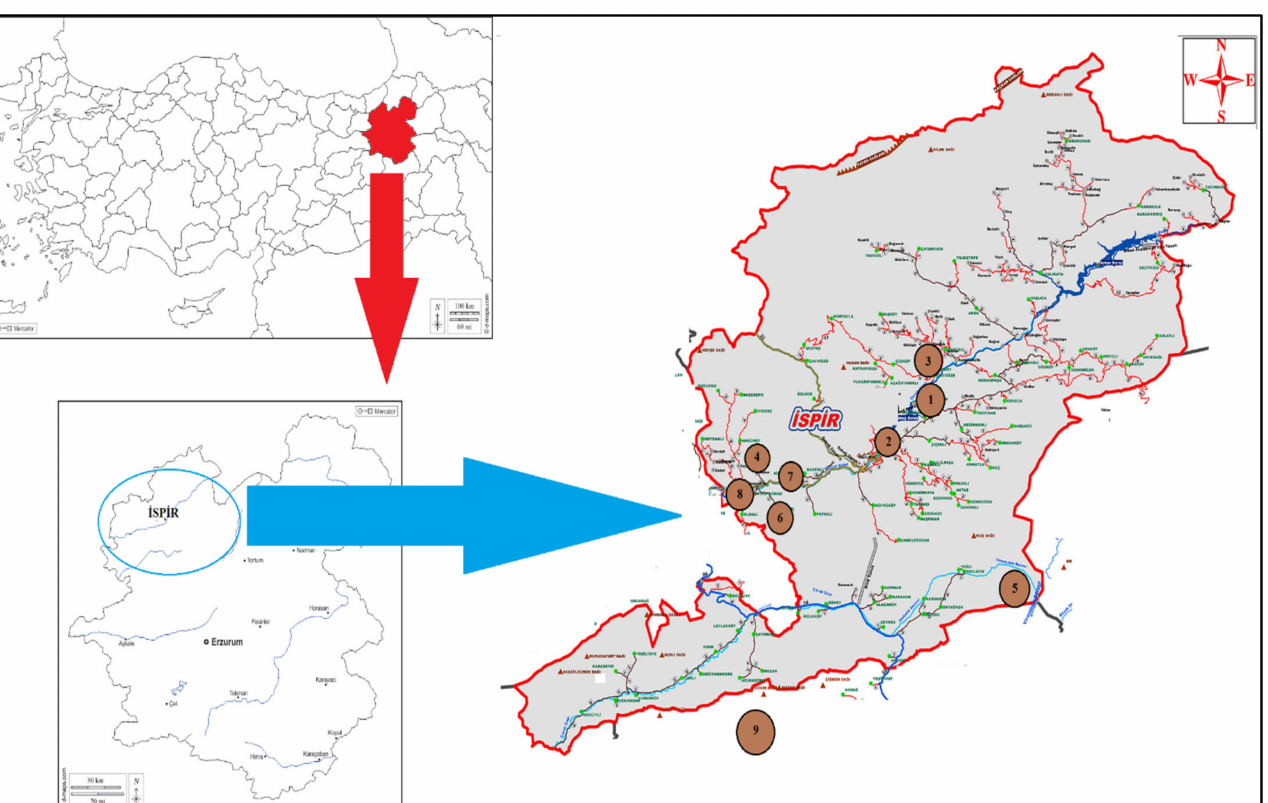
Figure 1. Geographic distribution of common bean landraces collected from different